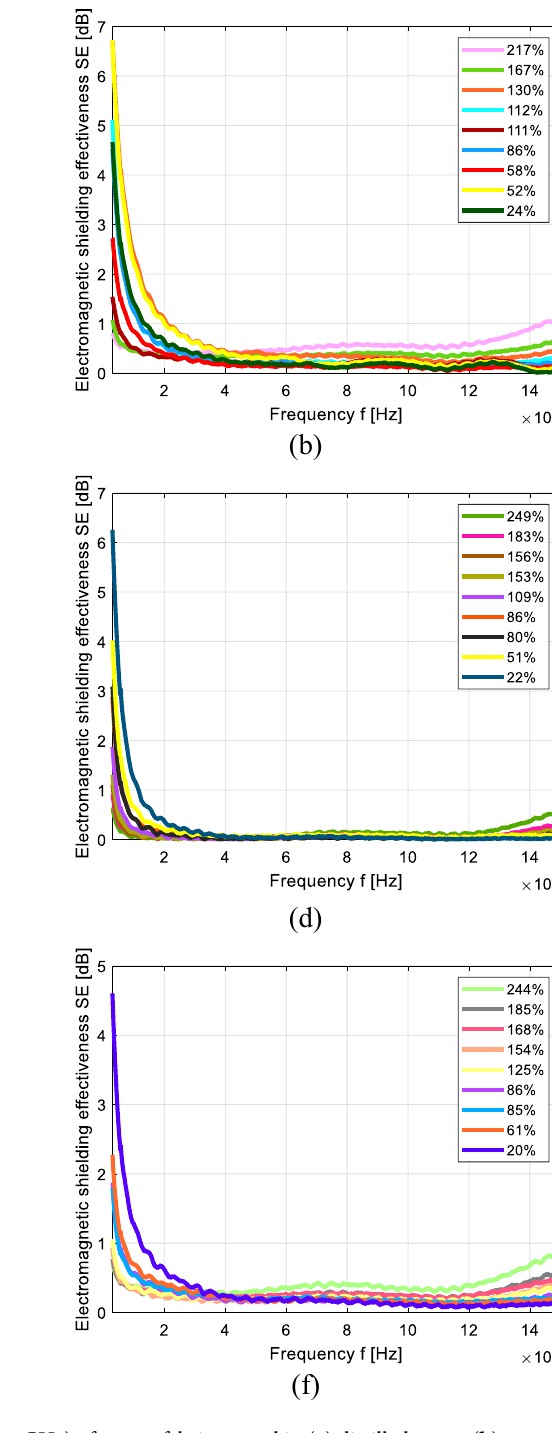
Figure 1. EM SE versus frequency (30 MHz to 1.5 GHz) of cotton fabric treated in ( a ) distilled water, ( b ) alkaline sweat and ( c ) acidic sweat. Polyester fabric treated in ( d ) distilled water, ( e ) alkaline sweat and ( f ) acidic sweat with different